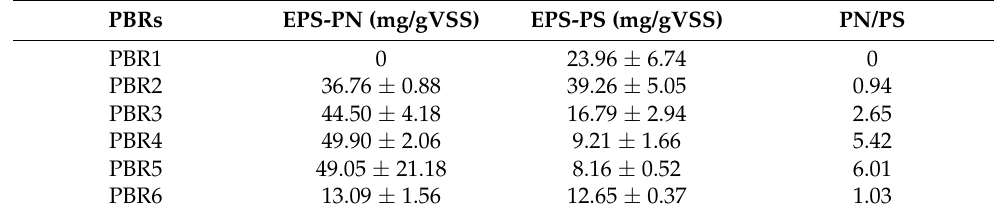
Table 3. Characterization of proteins (EPS-PN) and polysaccharides (EPS-PS) present in the biomass.